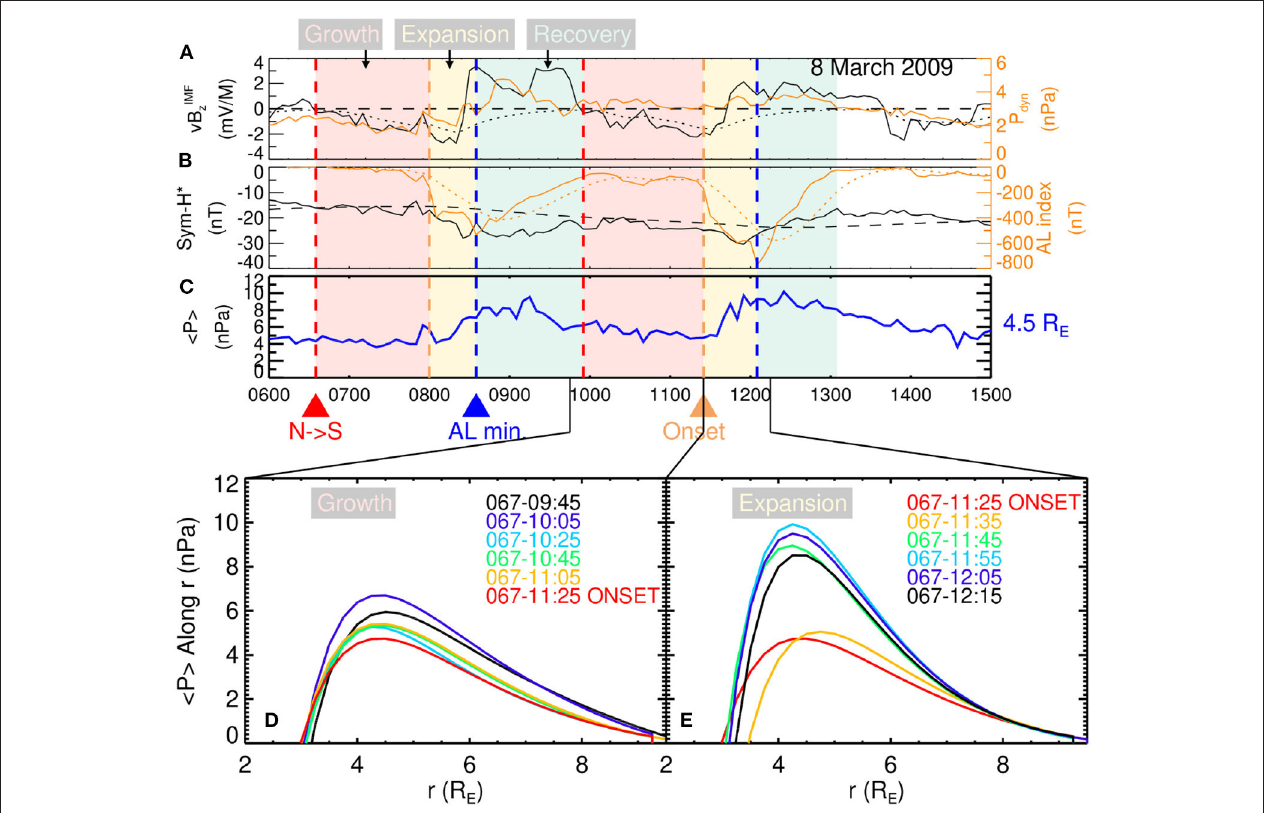
FIGURE 9 | Substorm enhancement of pressure. (A,B) Geomagnetic indices and solar wind parameters in a format similar to Figures 6a,b . (C) The value of the pressure averaged over all local times at r 4.5 R E . (D,E) The averaged pressure vs. radial distance at different times during the growth and expansion =